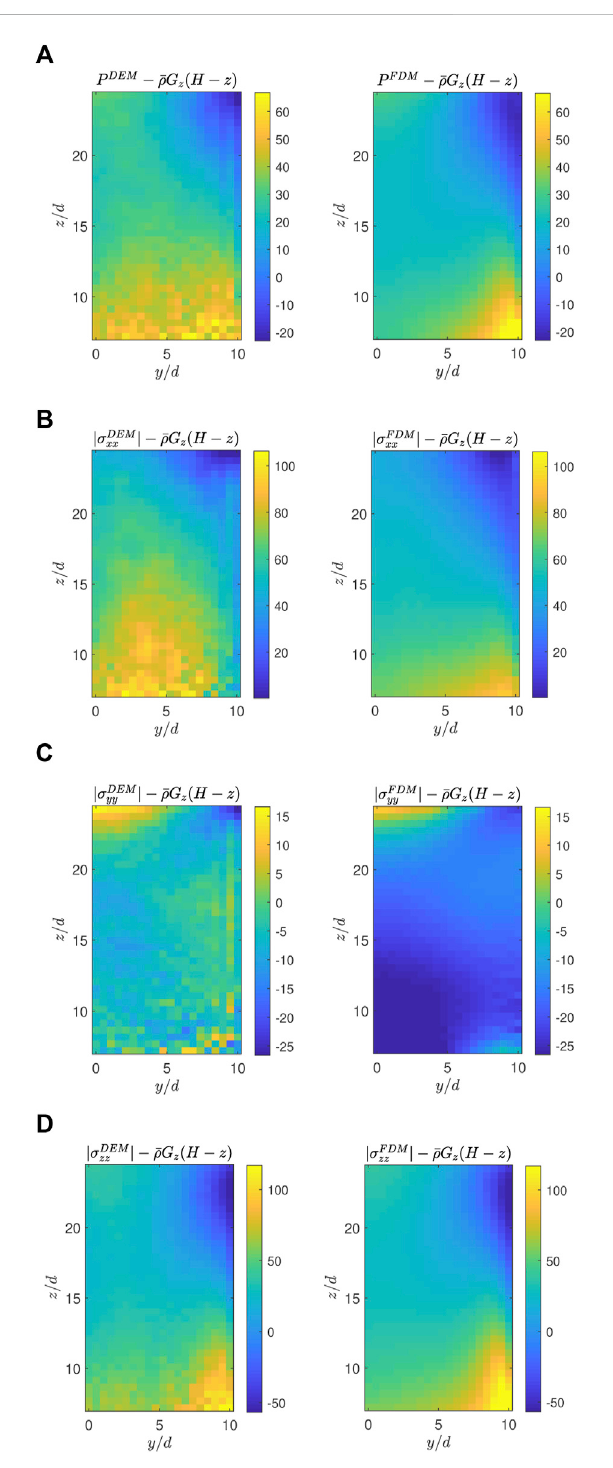
FIGURE 13 Comparison of pressure and normal stress maps between the DEM simulation (left) and the FDM simulation using the second-order model (right) with tan θ = 0.60: (A) P − (cid:2) ρ G z ( H − z ) , (B) | σ xx | − (cid:2) ρ G z ( H − z ) , (C) | σ yy | − (cid:2) ρ G z ( H − z ) , and (D) | σ zz | − (cid:2) ρ G z ( H − z ) where (cid:2) ρ G z ( H − z ) is a reference pressure linearly decreasing from 1.1 Pa × 10 3 Pa at z = 24.5 d to 54 Pa at z = 7 d .